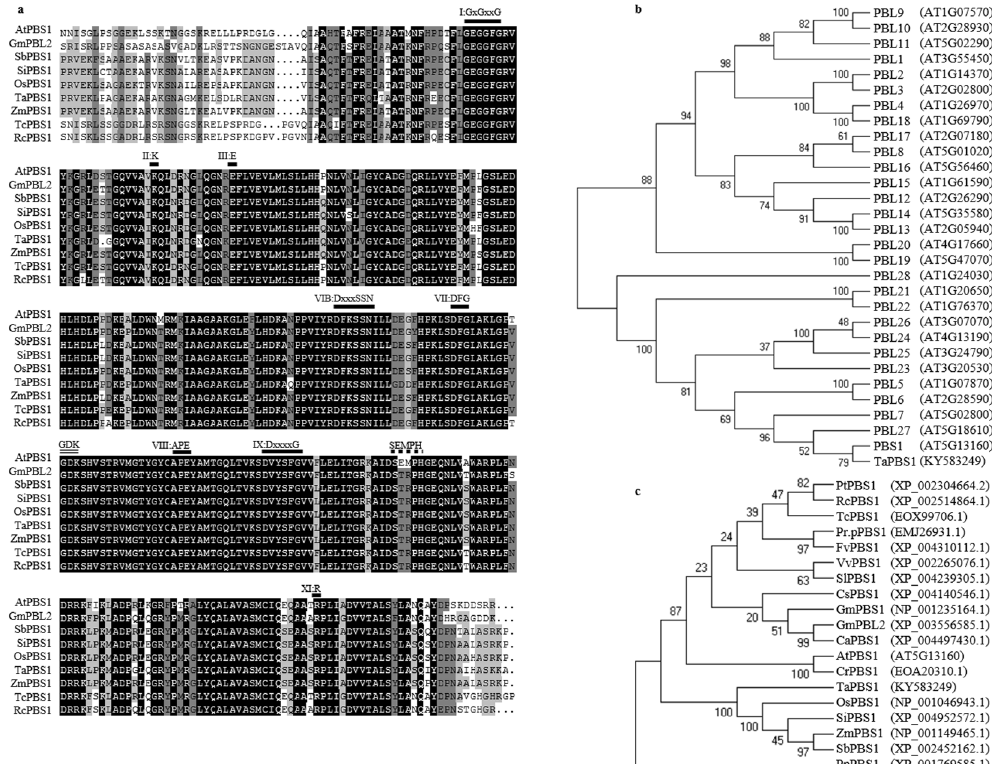
Figure 1. Phylogenetic analysis and multiple alignment of TaPBS1 and related proteins. ( a ) Amino acid sequence alignment of TaPBS1 with putative PBS1 orthologs from different plant species. Identical and similar amino acid residues are shown on black and gray backgrounds, respectively. The conserved kinase subdomains are labeled with Roman numbers above the aligned sequences. The AvrPphB cleavage site GDK and the SEMPH/STRPH motif are also labeled. ( b ) Phylogenetic analysis of TaPBS1 and Arabidopsis PBS1 paralogs. A neighbor-joining phylogenetic tree was constructed based on the deduced amino acid sequences of TaPBS1, PBS1 and 29 PBL proteins in Arabidopsis using MEGA5.0.3 software. ( c ) Phylogenetic analysis of PBS1 orthologs from different plant species. Ca : Cicer arietinum ; Gm : Glycine max ; Cs : Cucumis sativus ; Pt : Populus trichocarpa ; Rc : Ricinus communis ; Tc : Theobroma cacao ; Pr . p : Prunus persica ; Fv : Fragaria vesca ; Vv : Vitis vinifera ; Sl : Solanum lycopersicum ; At : Arabidopsis thaliana ; Cr : Capsella rubella ; Pp : Physcomitrella patens ; Ta :